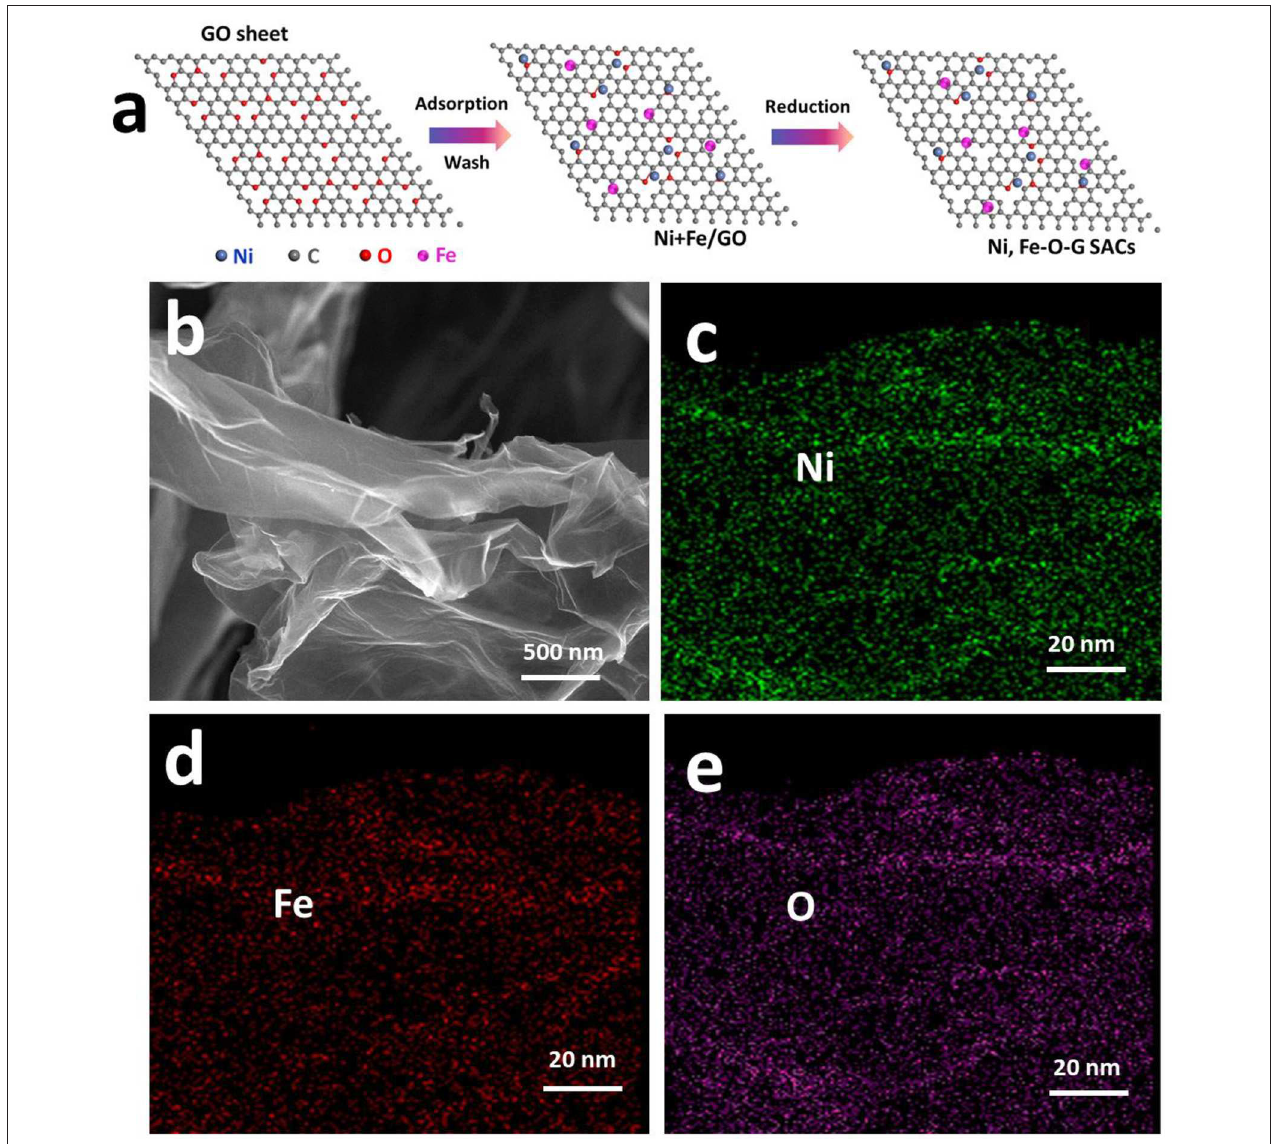
FIGURE 1 | (a) Schematic synthesis of Ni, Fe-O-G SACs. (b) SEM image of Ni 4 Fe 1 -O-G SACs. (c–e) elemental mapping images of Ni, Fe, O elements through the sheet of Ni 4 Fe 1 -O-G